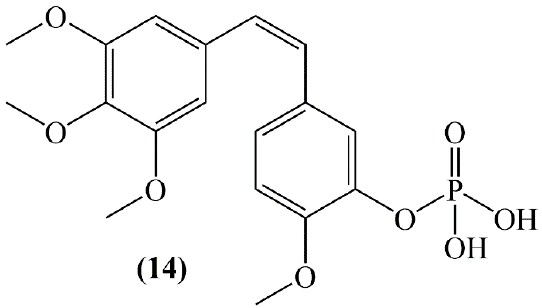
Figure 6. Structure of combretastatin A-4 phosphate (14) .